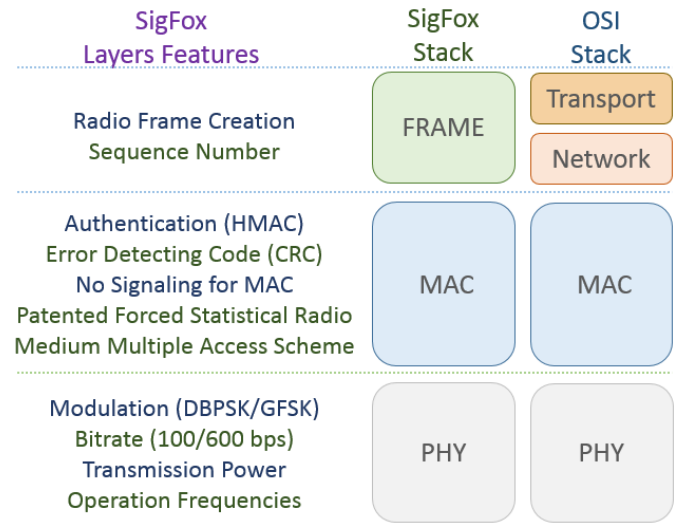
Figure 23. Sigfox protocol